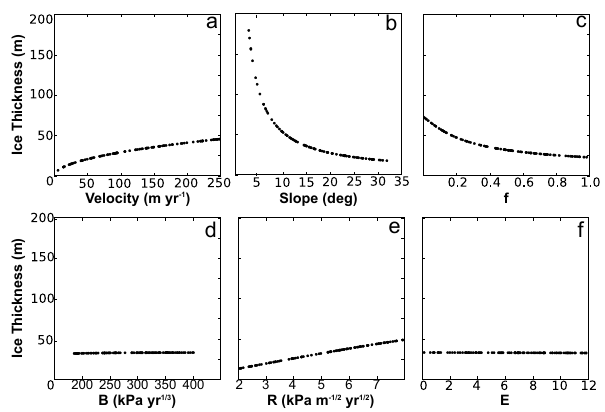
Figure 8. Sensitivity of computed ice thickness to model parameters and input data: computed ice thickness as a function of variations in (a) surface velocity, (b) surface slope α , (c) sliding factor f , (d) stiffness parameter B , (e) bed roughness factor R and (f) enhance- ment factor E (see Eqs. 5 and